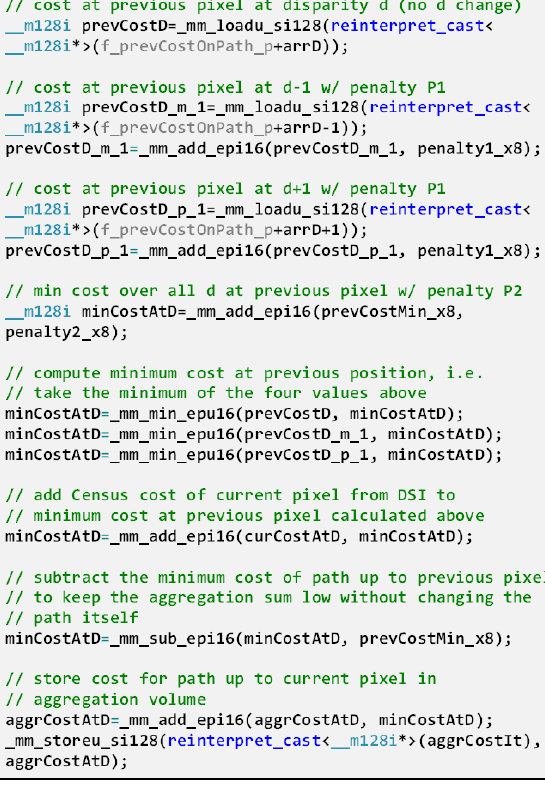
Figure 5. C++ snippet with SSE2 intrinsics for cost aggregation purpose, the optimized SGM implementation is passed a set of RGB stereo images of a synthetic 3D scene (Frommholz, 2019).